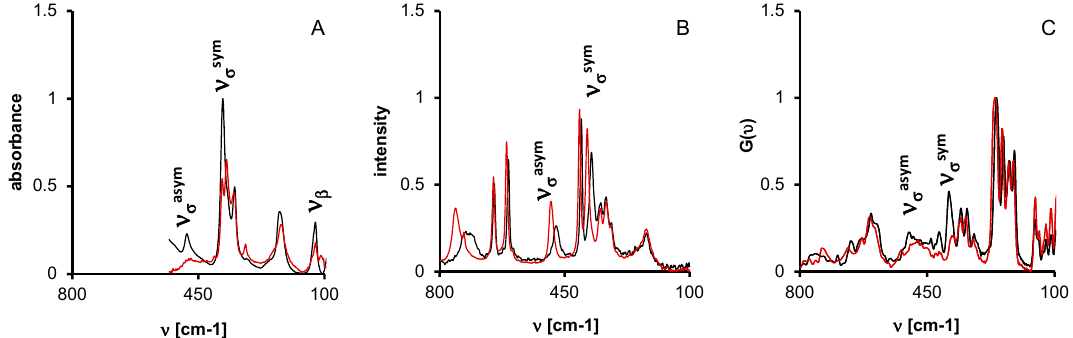
Figure 10. The infrared spectra (absorbance, A ), Raman (intensity, B ), and IINS ( G ( v ), C ) of 1,1 ′ ,1 ″ -(2,4,6-trihydroxybenzyl-1,3,5-triyl)triethanone (black line) and their deutero-derivatives (red line). Ref. [46] – Adapted by permission of The Royal Society of Chemistry (RSC) on behalf of the Centre National de la Recherche Scientifique (CNRS) and the RSC.